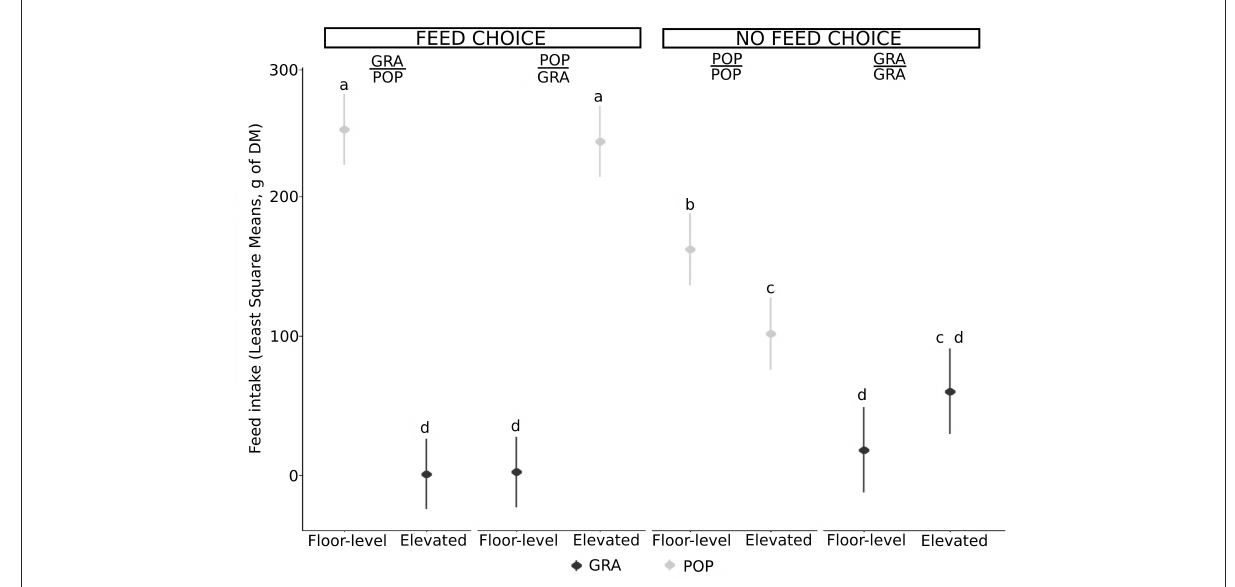
FIGURE3 Least Square ( ± SE) of the quantity of each feed type (GRA: cut grass and POP: poplar leaves) eaten from each feeder (elevated feeder and floor-level feeder) per goat ( n = 16, with two repetitions per individual) for Exp1, depending on the combination of feed type and feeding posture (Elevated/Floor: POP/POP, GRA/GRA, POP/GRA and GRA/POP), grouped according to the possibility of choosing a feed item or not. Tests where no feed was eaten have been excluded ( n = 2 GRA/GRA). The dot and bars represent the LSmean and standard error of each combination. Significant differences indicated by the model ( P < 0.05) are represented by different letters. The interaction between the feed type, the feeding posture, and the possibility to choose between feed or not was significant.